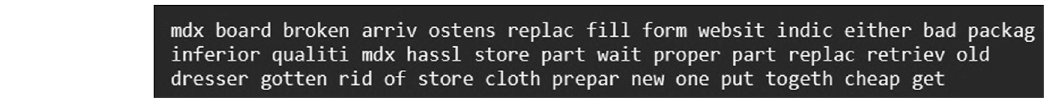
FIGURE 4 | Simple OCR after text preprocessing step.